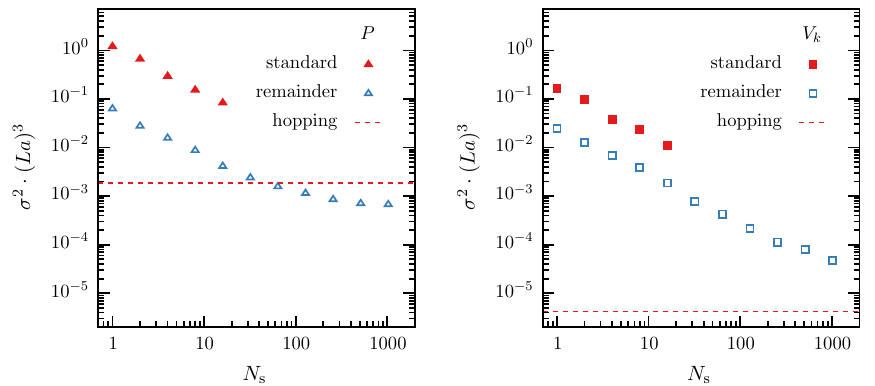
(remainder, open the variances of the standard random noise estimators (filled red sym- (cid:6), r (hopping, dashedredlines)forthesame bols)andthegauge noiseof ¯ t M (cid:6), r mass are also shown